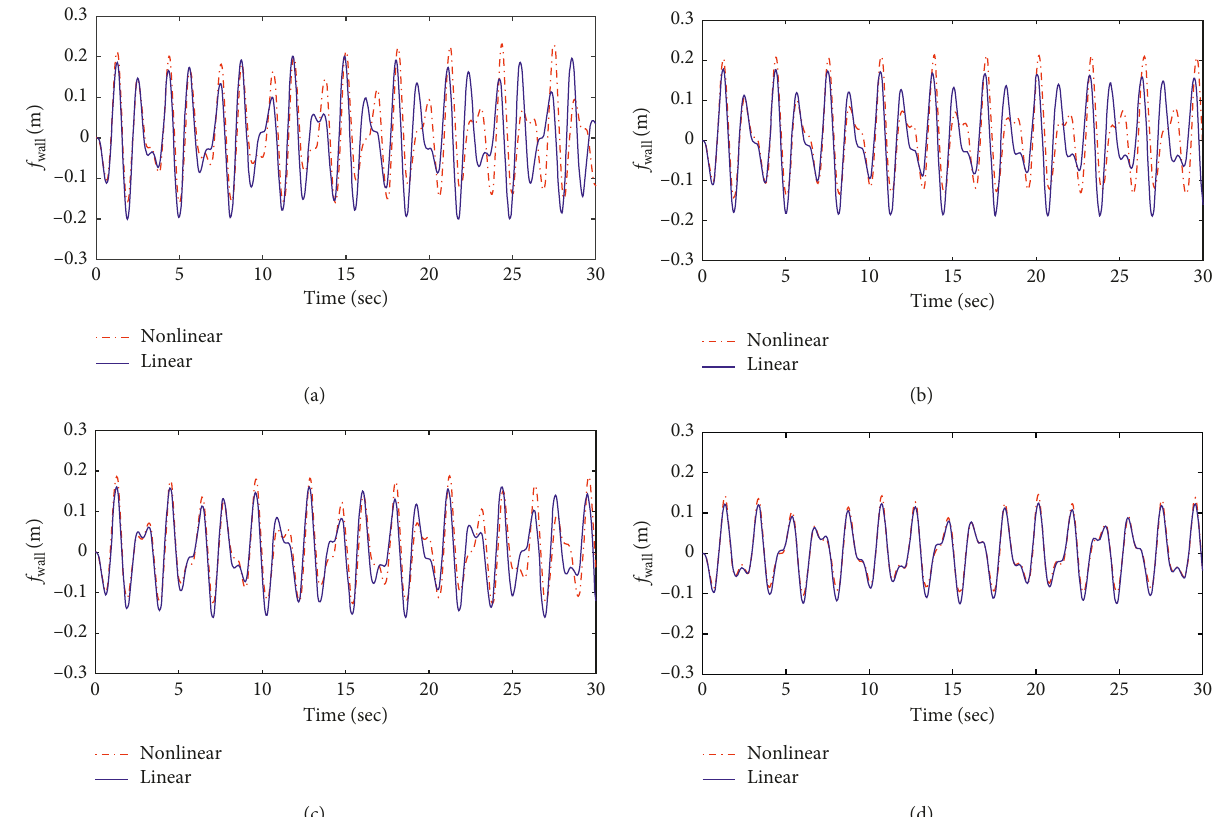
The position of the baffle z 1 (m)